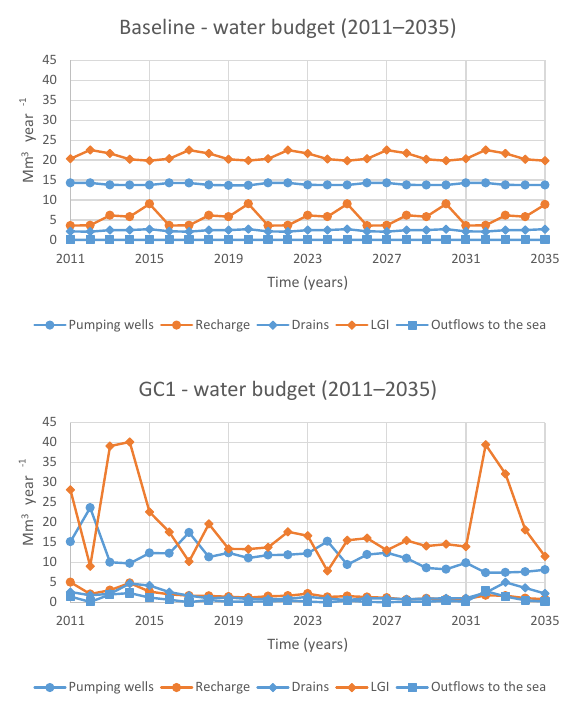
Figure 12. Components of the flow budget evolution for the BL sce- nario and the GC1 scenario (horizon